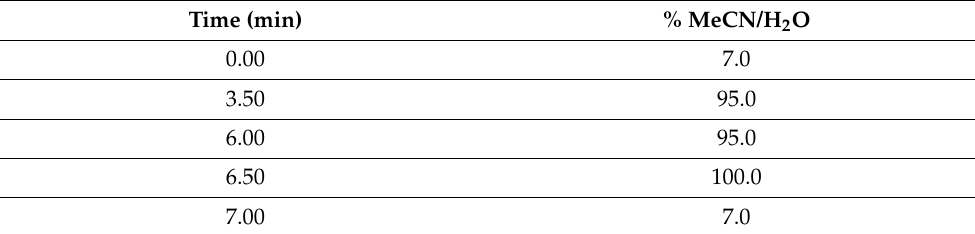
Table 3. Gradient elution